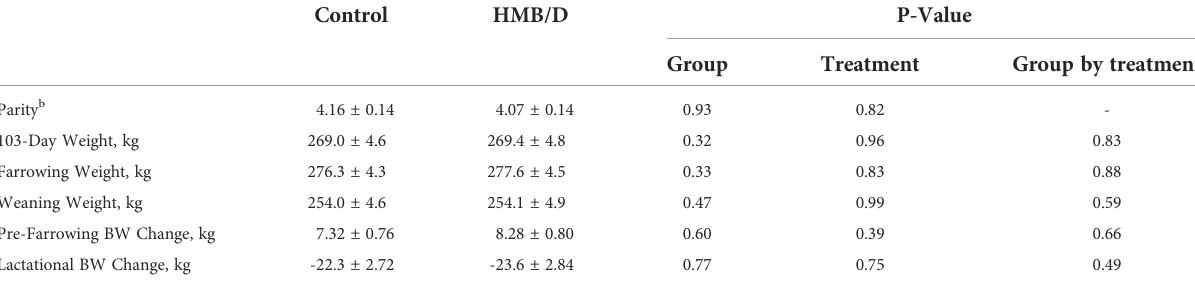
TABLE 1 The effect of supplementing with calcium beta-hydroxy-beta-methylbutyrate and vitamin D (HMB/D) during late gestation and lactation on sow weights and condition in trial 1 a